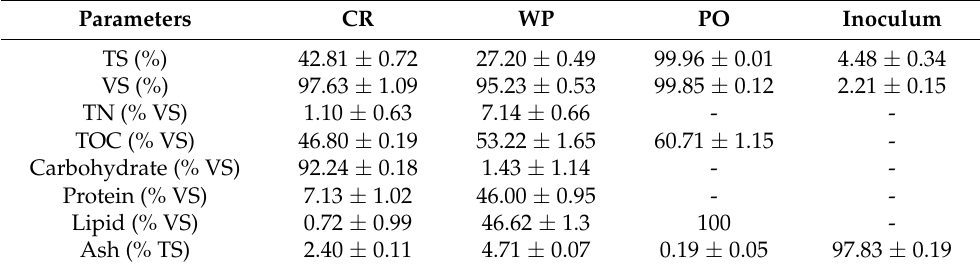
Table 1. Characteristics of substrates.